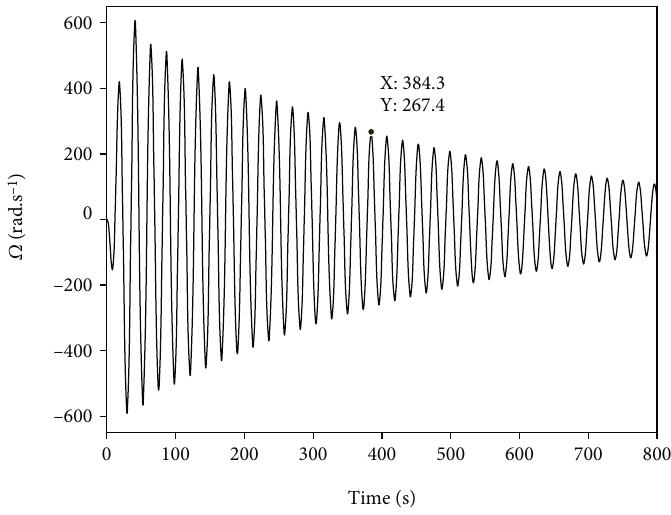
Figure 5: Rotational speed of the RW actuator with constant-gain